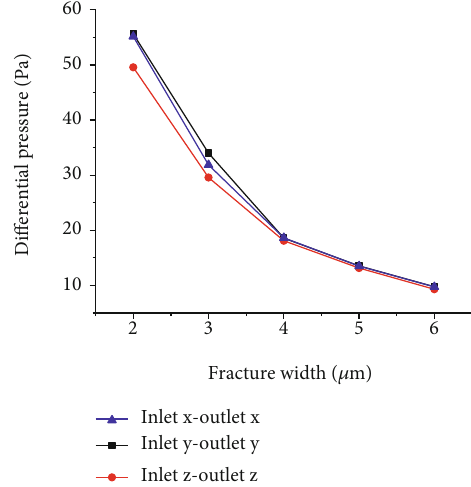
Figure 3: Di ff erential pressure of fl uid fl ow with di ff erent fracture width.